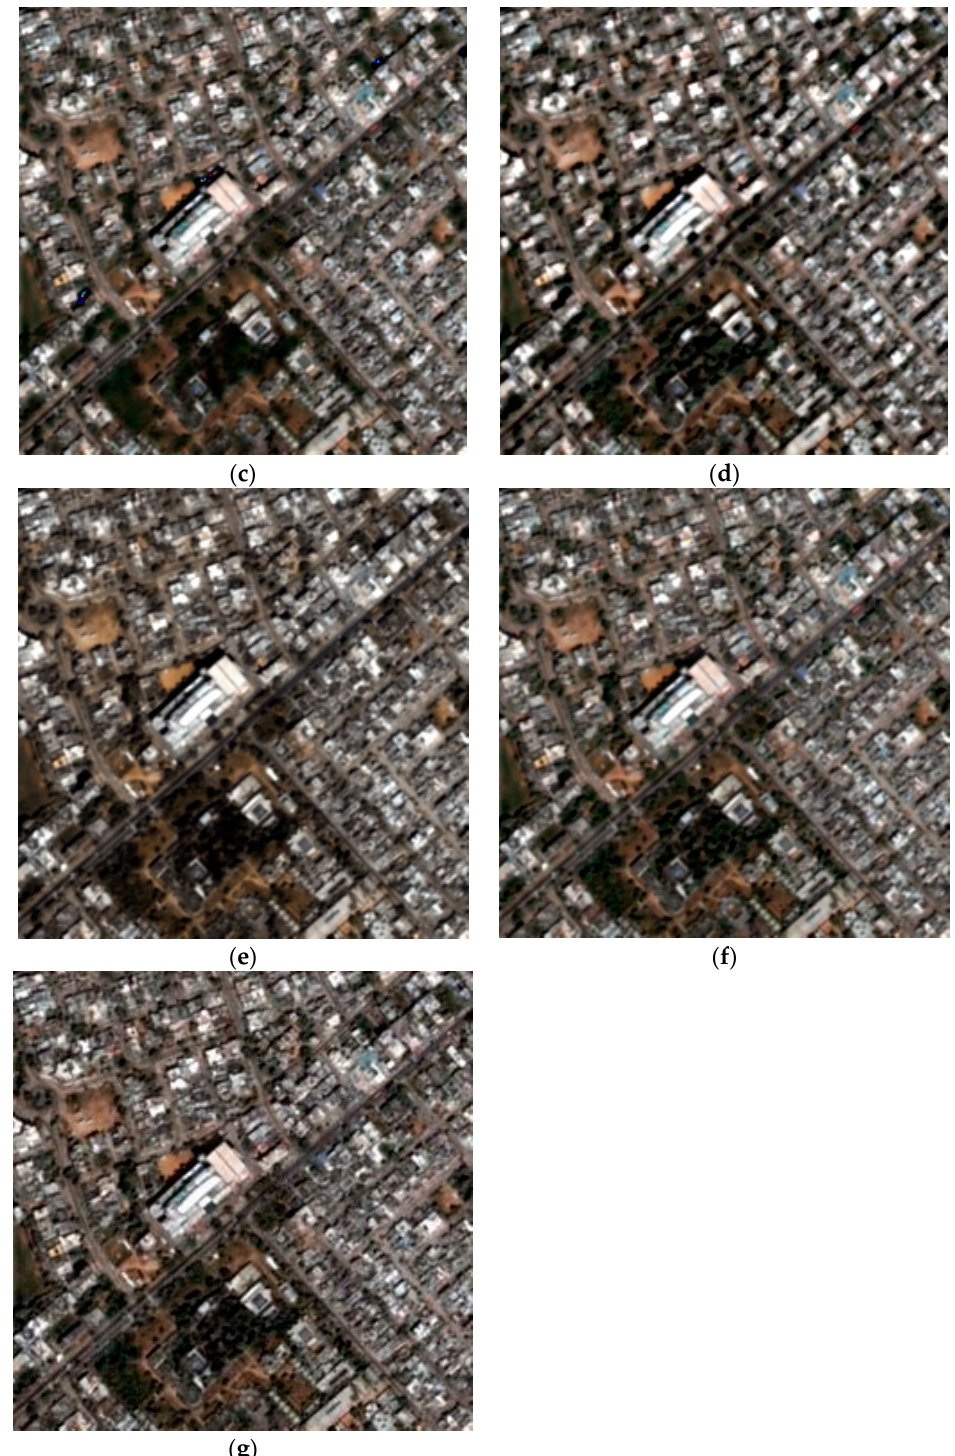
Figure 7. Simulated results of the Quickbird dataset. ( a ) Ground truth; ( b ) PCA; ( c ) SFIM; ( d ) MTF-GLP; ( e ) PNN; ( f ) DiCNN; ( g ) proposed.